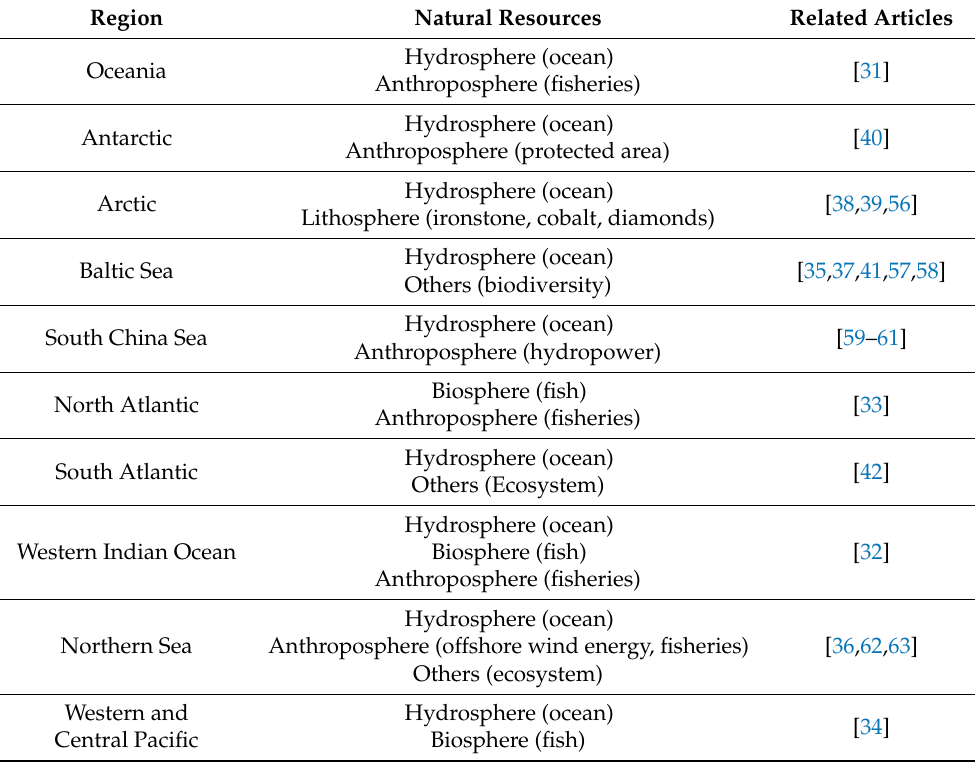
Table 3. Regional studies regarding the continental and ocean levels. Region Natural Resources Related Articles